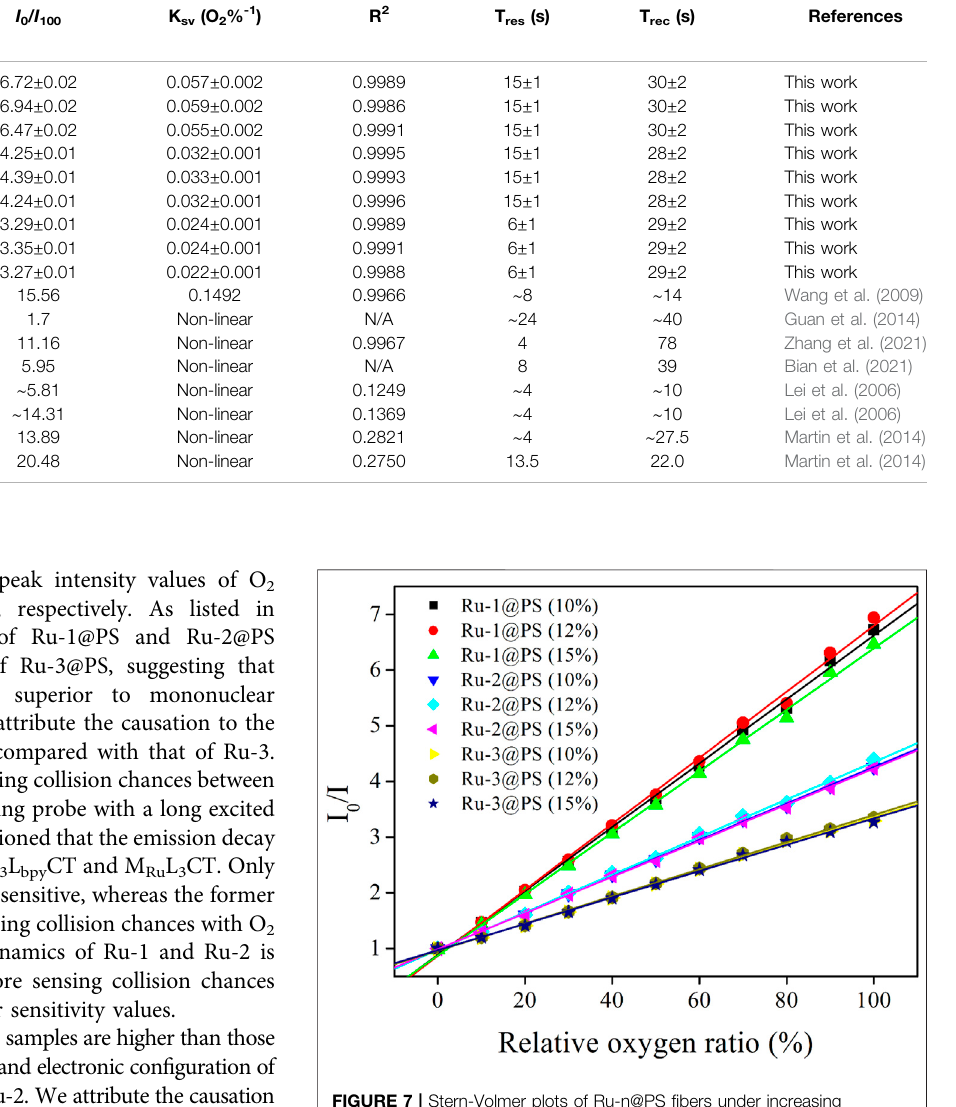
FIGURE 7 | Stern-Volmer plots of Ru-n@PS fi bers under increasing oxygen concentrations from 0% to